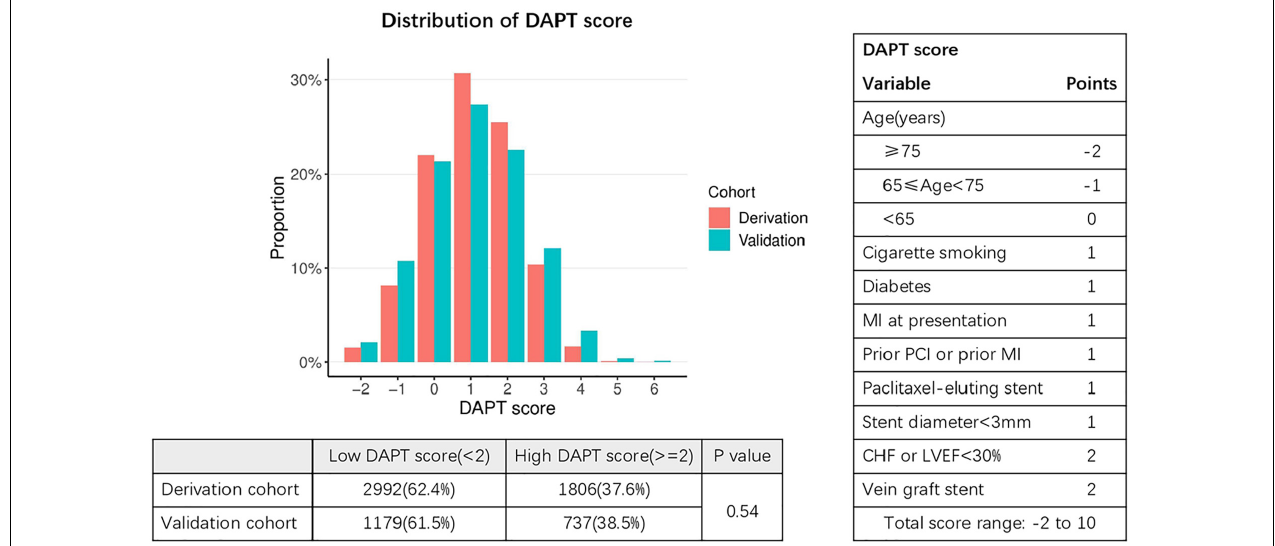
FIGURE 2 | Distribution of DAPT scores in the derivation and validation cohorts. Fisher exact test was used to compare distribution of patients with low DAPT score ( < 2) and high DAPT score ( ≥ 2) in the derivation and validation cohorts. DAPT, dual antiplatelet therapy; MI, myocardial infarction; PCI, percutaneous coronary intervention; CHF, congestive heart failure; LVEF, left ventricular ejection fraction. The X-axis represents DAPT score, while the Y-axis represents proportion.